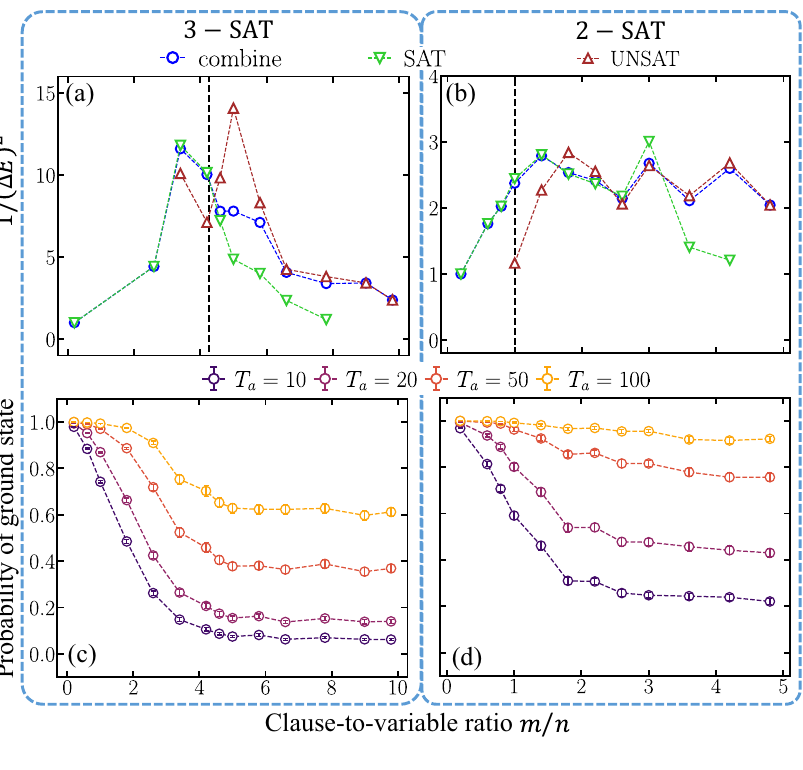
Fig. 6 QAA gap size and performance for k -SAT problems. a , b The median of 1/ Δ E 2 of QAA with n = 10 variables shown by blue circles. The green and purple circles represent the SAT and UNSAT instances separately. c , d The probability of the fi nal state after QAA evolution being in (cid:9) (cid:8) P D the ground state, P ¼ j ψ i j ϕ QAA j 2 . All results and error bars are estimated over 100 i ¼ 1